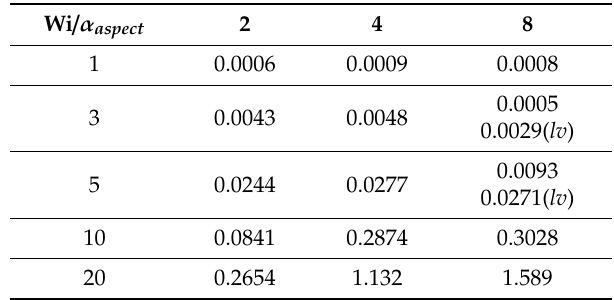
Figure 12. Vortex-intensity ( − Ψ min ) against Wi ; α aspect = {2, 4, 8}; swIM [ L = 5, β ≤ 0.9]; Table 2. Vortex-intensity ( − Ψ min ); α aspect = {2, 4, 8}; Wi = [1, 20]; swIM [ L = 5, β ≤ 0.9]; λ D =